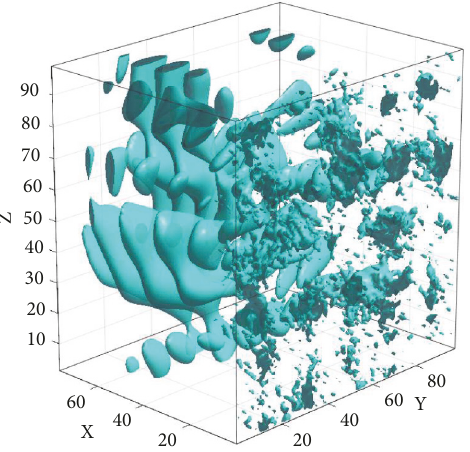
Figure 5: The isosurface of the 𝐸 𝑥 field amplitude domains (arbi- trary units) as solution to the nonlinear system (1)–(4) in a total 3D system with a percolating cluster at 𝑝 = 0.28 and 𝑡 = 7 . In the right (entrance into cluster), the small point-like field peaks correspond to radiating emitters pinned to the percolating cluster are seen. We observe a number of smooth closed 3D localization field domains for large 𝑥 at the left side beyond the emitters